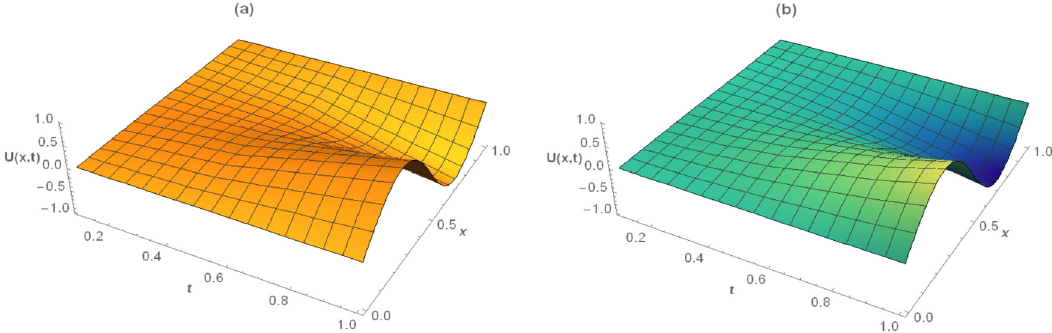
Figure 4: Graphs of approximate solutions for di ff erent time levels at ( a ) α 0.5 = part and ( b ) α 0.75 =